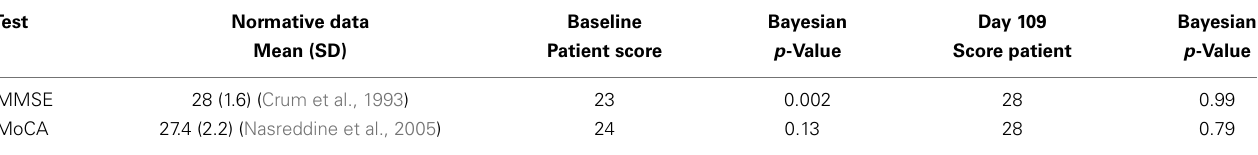
Table 1 | Outcomes